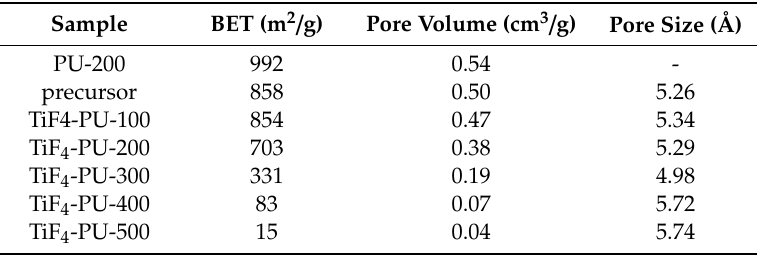
Table 1. Specific surface area, pore volume, and pore size of the TiF 4 -PU-T catalysts calcined at di ff erent